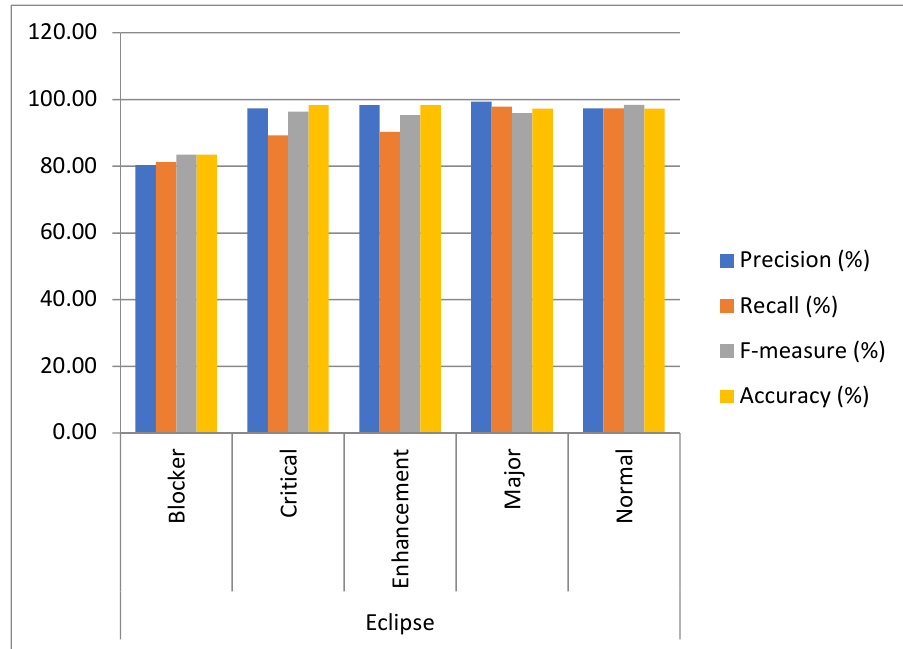
Figure 6. Results analysis of the proposed BCR on seven classes of the Firefox Project. Sensors 2018 , 18 , x FOR PEER REVIEW